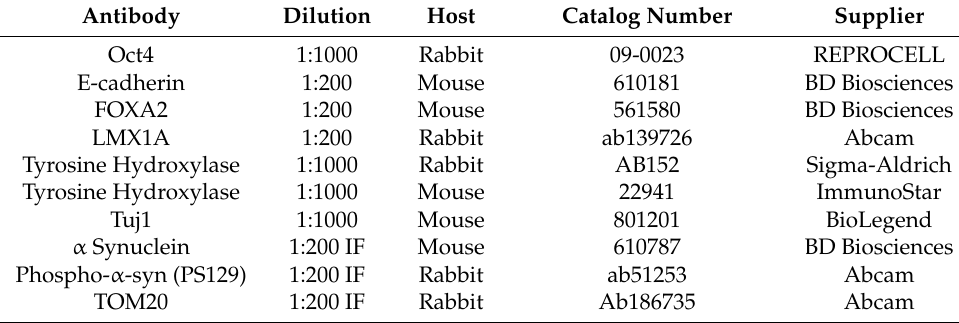
Table 2. Appropriate Alexa Fluor 488- or 594-conjugated secondary antibodies (Thermo Fisher) were used. Finally, cells were mounted in FluorSave (EMD Millipore, 345789) with 4 (cid:48) ,6-diamidino-2-phenylindole (DAPI, Sigma D9542) staining. Images were acquired with a Leica DMI 6000B microscope. Table 2. List of antibodies used in this